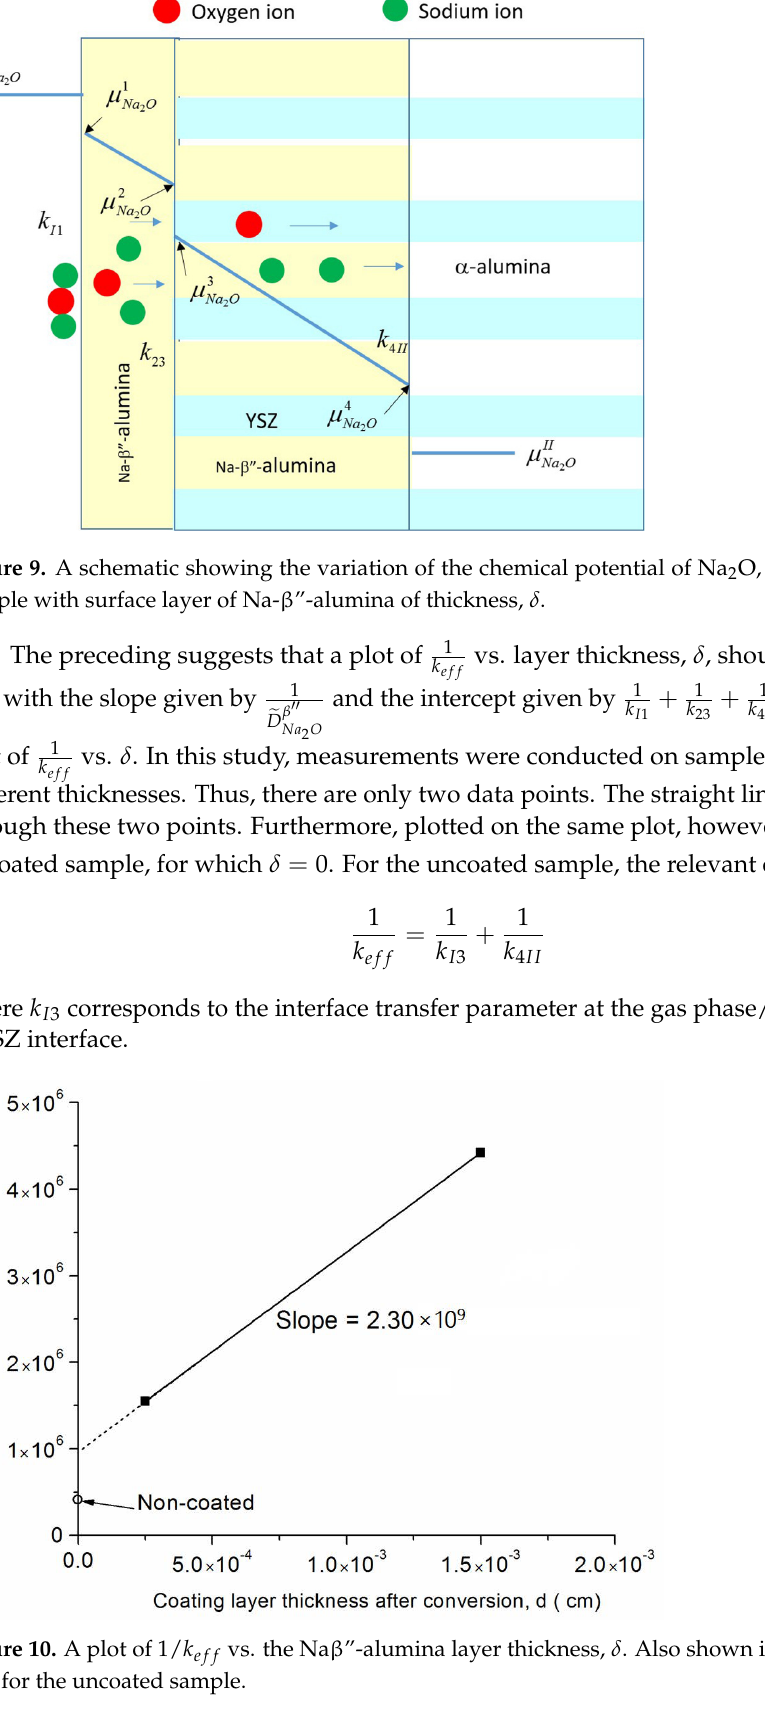
Figure 10. A plot of 1/ k ef f vs. the Na β ”-alumina layer thickness, δ . Also shown in the figure is the k ef f for the uncoated